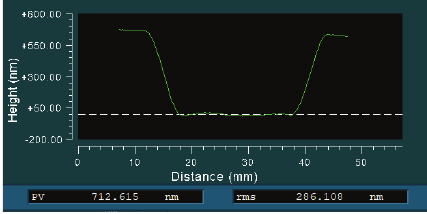
Figure 3. Interferometric measurement of asphere before and after